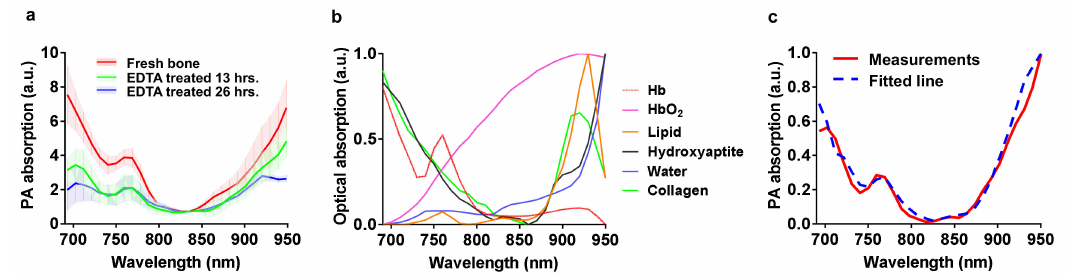
Figure 3. ( a )TheaveragedPAspectrameasuredfromthethreegroupsofporcineribs, includingfreshbones (Group 1), bones treated with EDTA for 13 h (Group 2), and bones treated with EDTA for 26 h (Group 3). ( b ) Optical absorption spectra of major chemical components in the bone, including hydroxyapatite, collagen, oxyhemoglobin (HbO2), deoxygenated hemoglobin (Hb), lipids, and water. ( c ) The averaged PA spectrum from Group 2 (the bones treated with EDTA for 13 h) in comparison with the fitted spectrum by using the least-squares